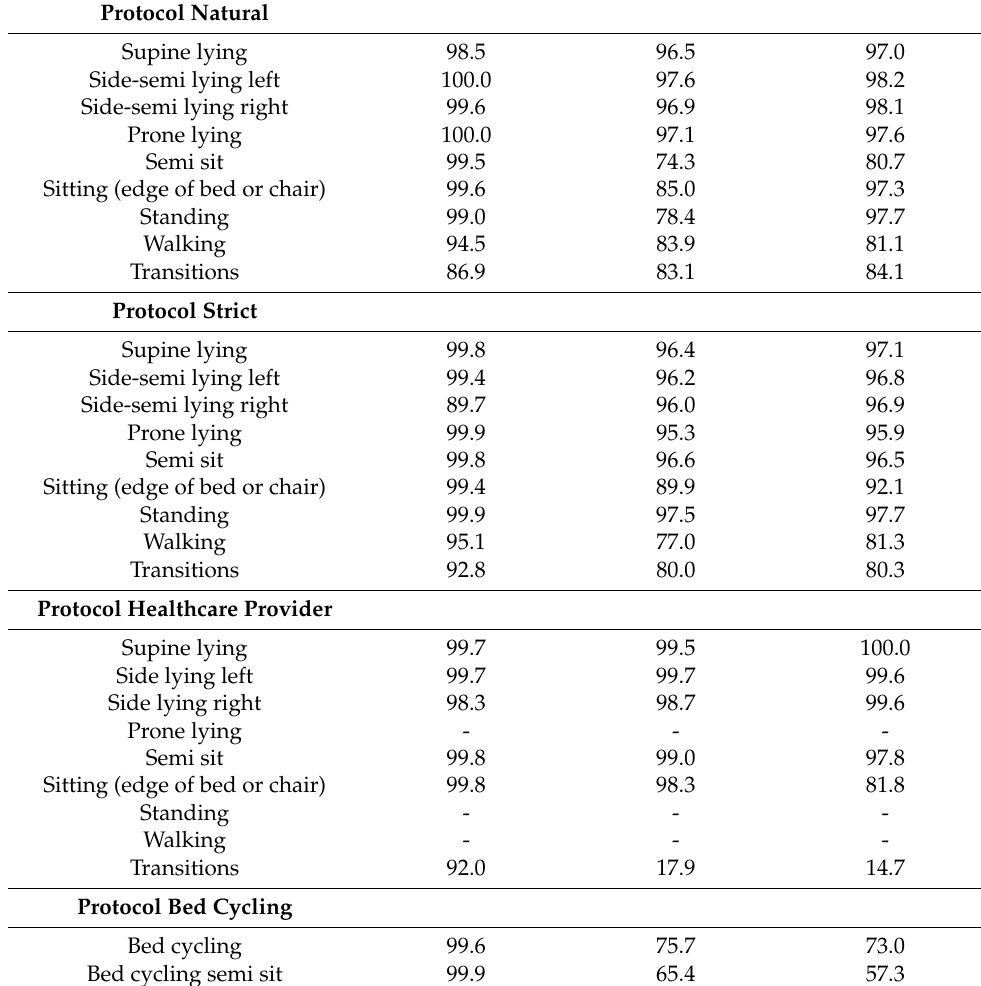
Table A3. Absolute Values Represented as %Agr of the Algorithm Related to the Video for the Validation Group ( n =